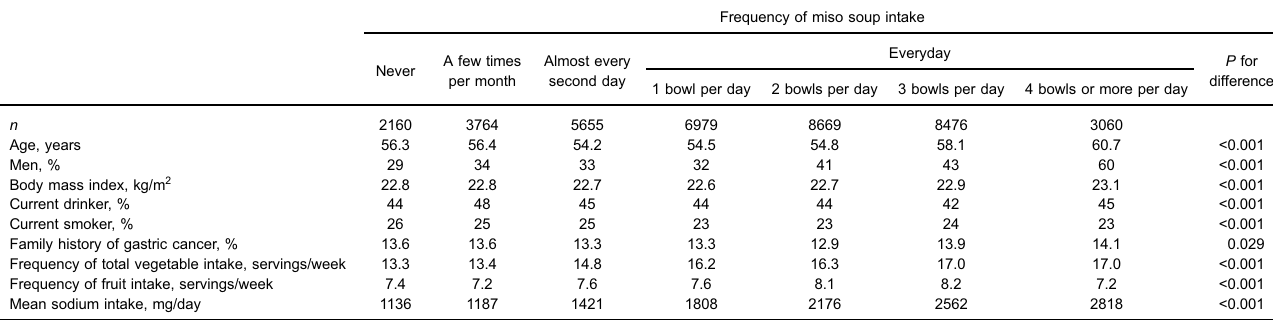
Table 2. Age- and sex-adjusted characteristics of the subjects according to frequency of miso soup